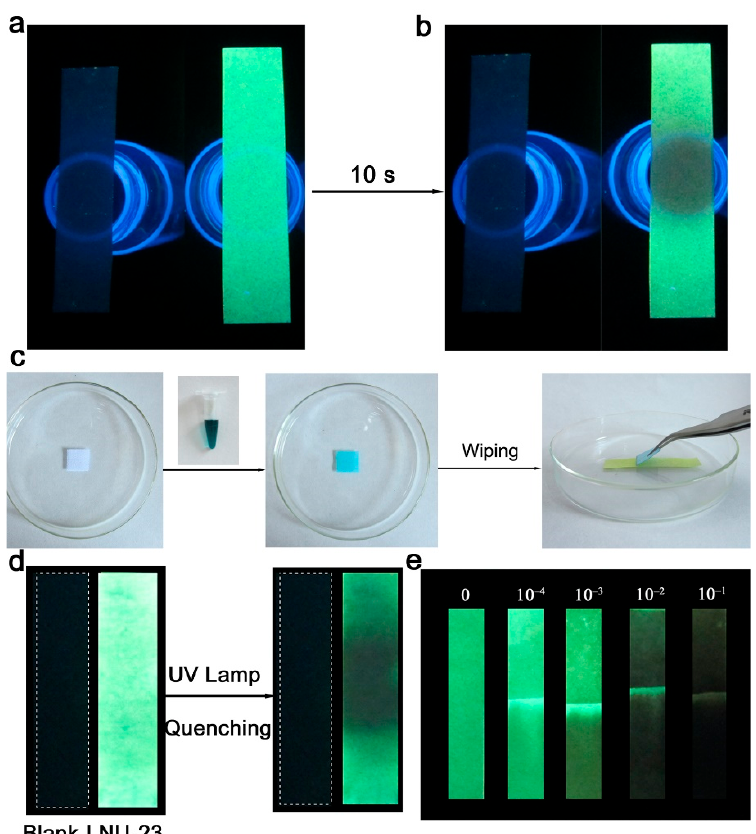
Figure 5. ( a ) Fluorescence diagram of indicator paper loaded with LNU-23. ( b ) Fluorescence diagram of indicator paper loaded with LNU-23 after the contact with gaseous nitrobenzene. ( c ) Process diagram of indicator paper for detecting solid nitrobenzene. ( d ) Diagram of indicator paper for detecting liquid nitrobenzene. ( e ) Fluorescence diagram of indicator papers in the presence of different concentrations of liquid nitrobenzene.